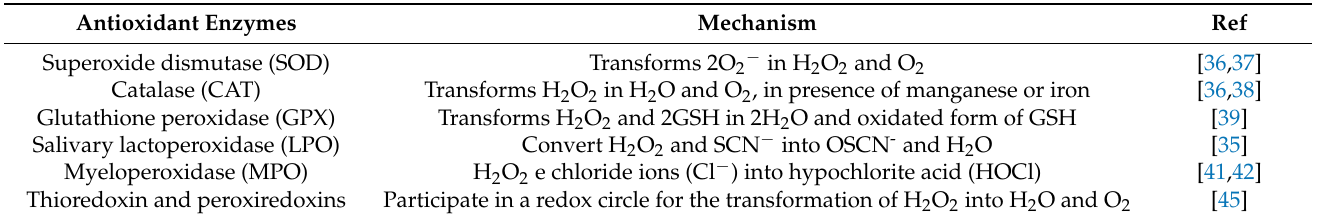
Table 1. List of the antioxidants enzymes and their reaction to remove reactive oxygen metabo- lites